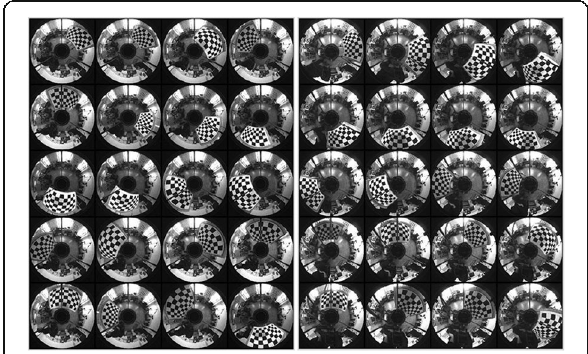
Fig. 9 Images used for omnidirectional camera calibration. On the left are pictures captured by the upper omnidirectional camera. On the right are pictures captured by the lower omnidirectional camera